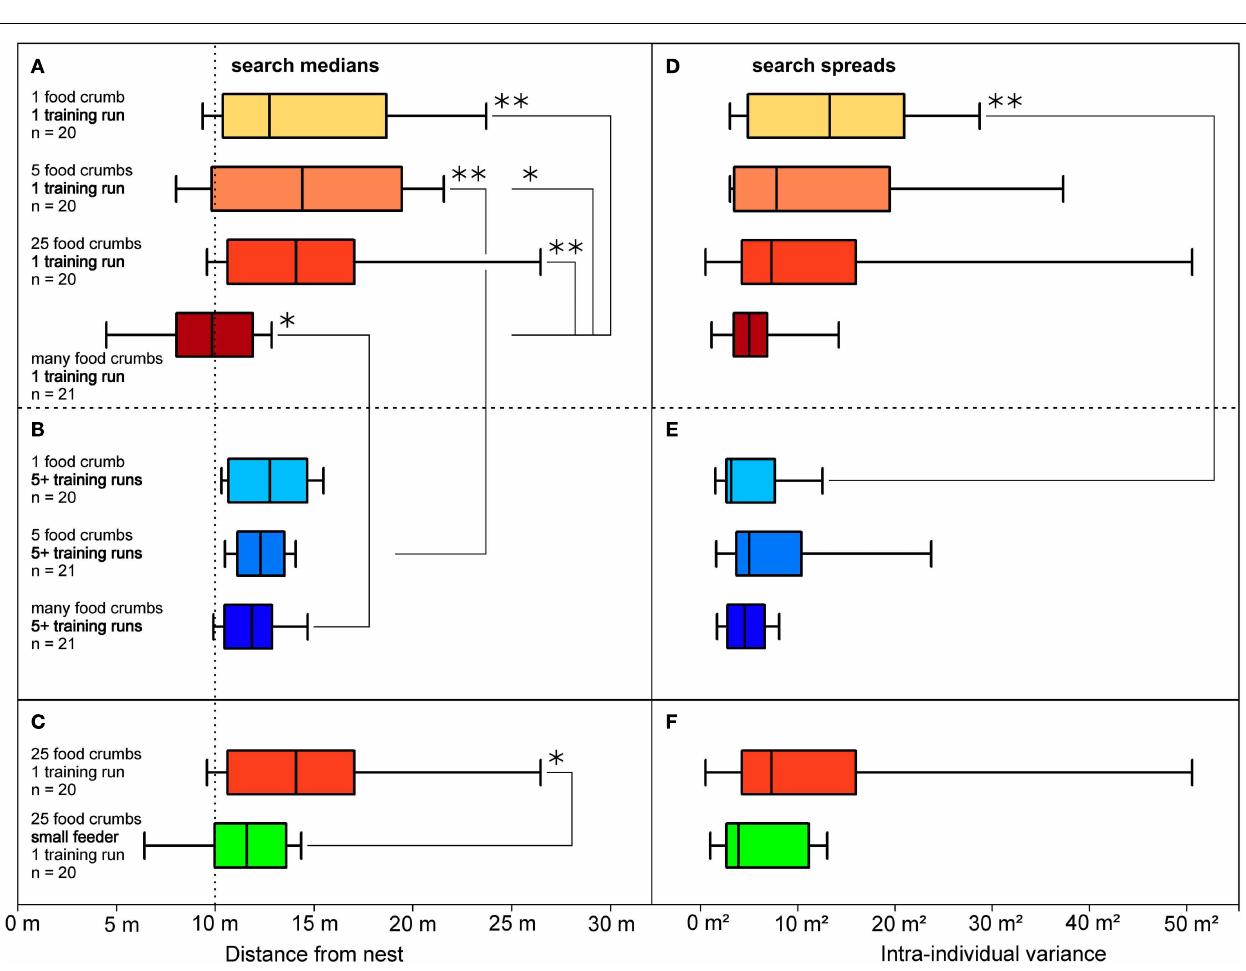
FIGURE 3 | Distributions of food searches (A,D), according to their dependency on the amount of food presented, and (B,E) according to rewarded experience with the feeding site. (A,D) Data from ants that had performed a single (training) visit to a feeder located in a channel, 10m from the nest.The experimental groups differed in the amount of food available in the feeder, as noted on the left and indicated by the box color (darker colors represent more food items). Also noted are numbers of experimental animal. Boxes and whiskers as in Figure 2 . Significant differences are indicated by brackets and asterisks; one asterisk, p < 0.05; two asterisks, p < 0.01;